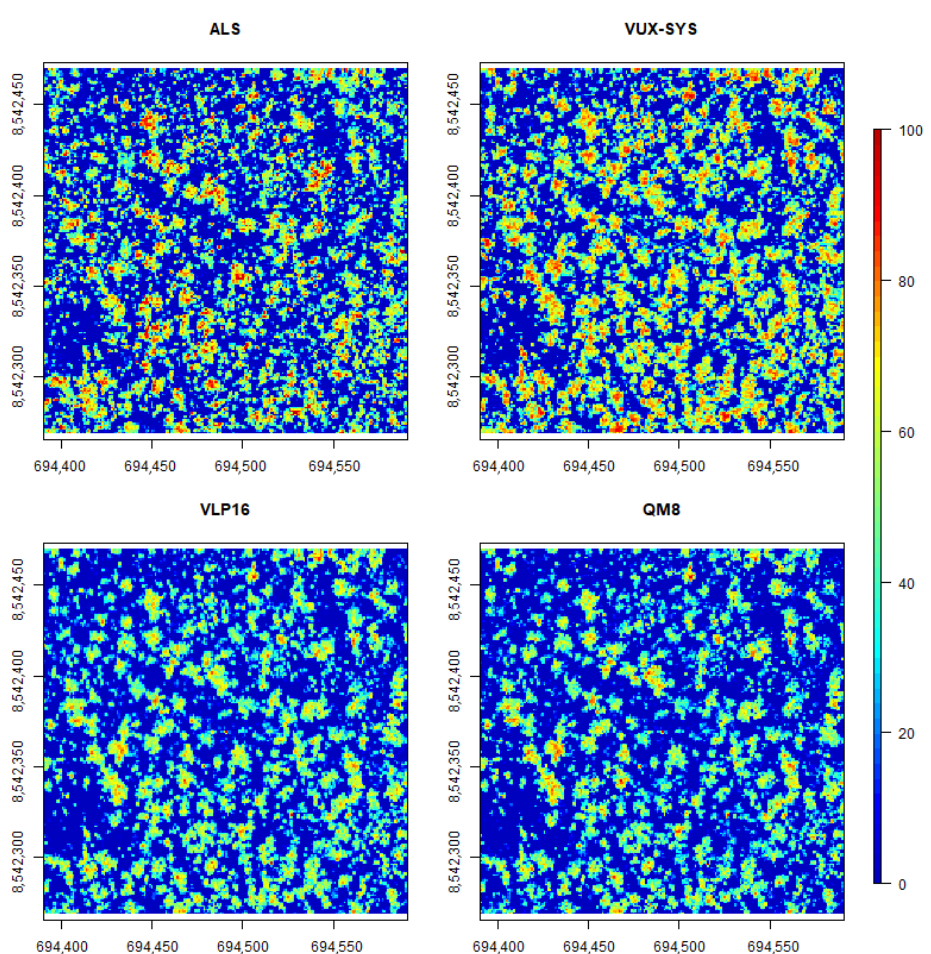
Figure 9. Canopy cover (%) acquired by the different sensors (pixel size = 1 m). The area shown covers the 200 × 200 m study area; coordinates on the x and y axes are given in UTM Zone 52S. Large differences in canopy cover can be observed between the different datasets.